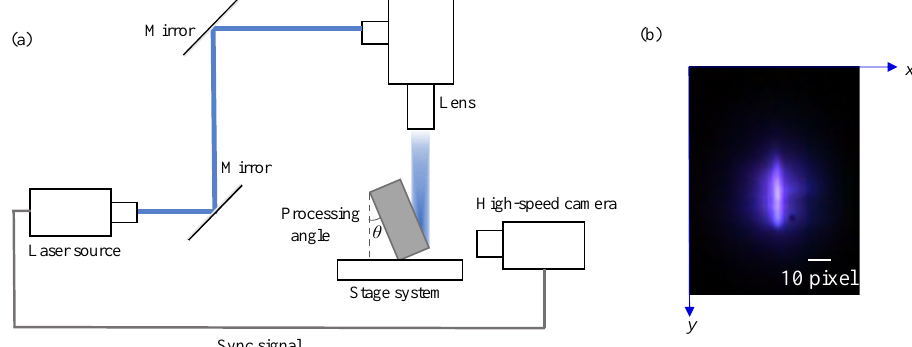
Figure 3. ( a ) Schematic of PLG system with a sync signal and high-speed camera for plasma visual- ization. ( b ) Image of plasma acquired by high-speed camera.